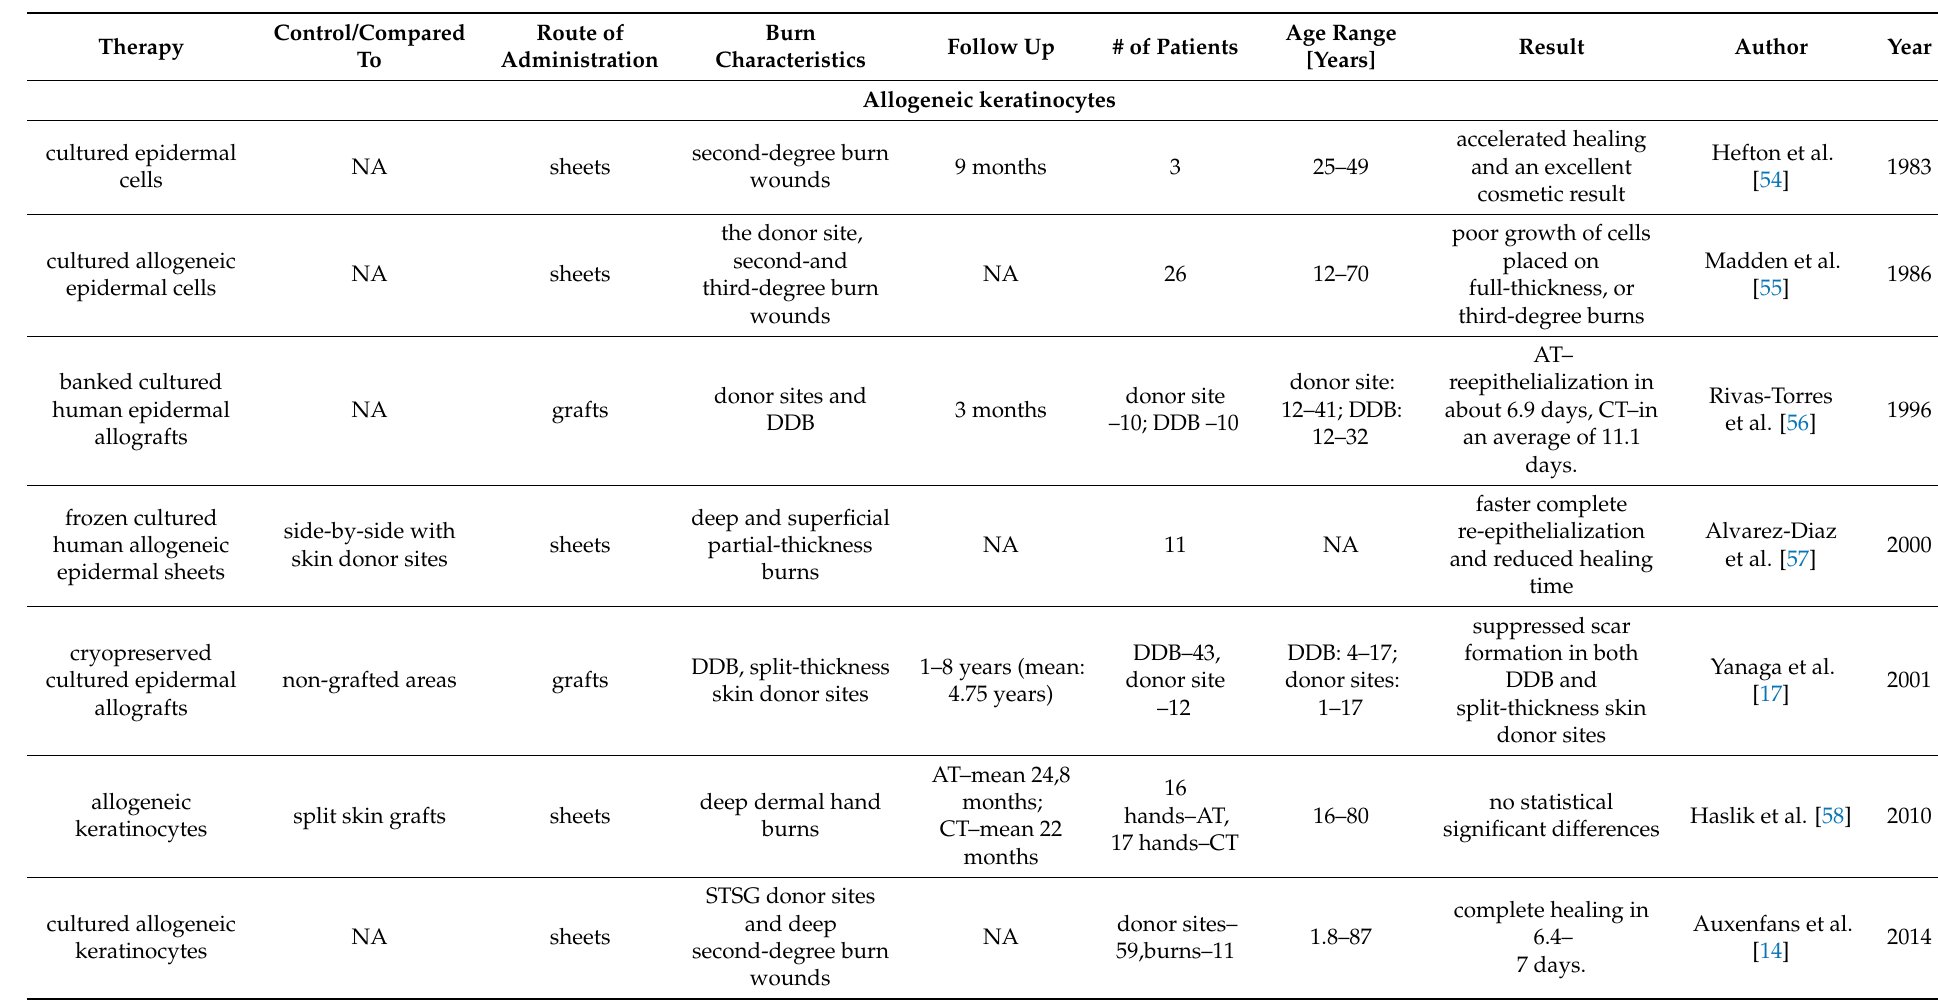
Table 2. Clinical use of allogeneic keratinocytes and fibroblasts in burns (NA—not available, AT—active treatment, CT—control group, DDB—deep partial-thickness burn wounds, STSG—split-thickness skin graft, CDS—cultured dermal